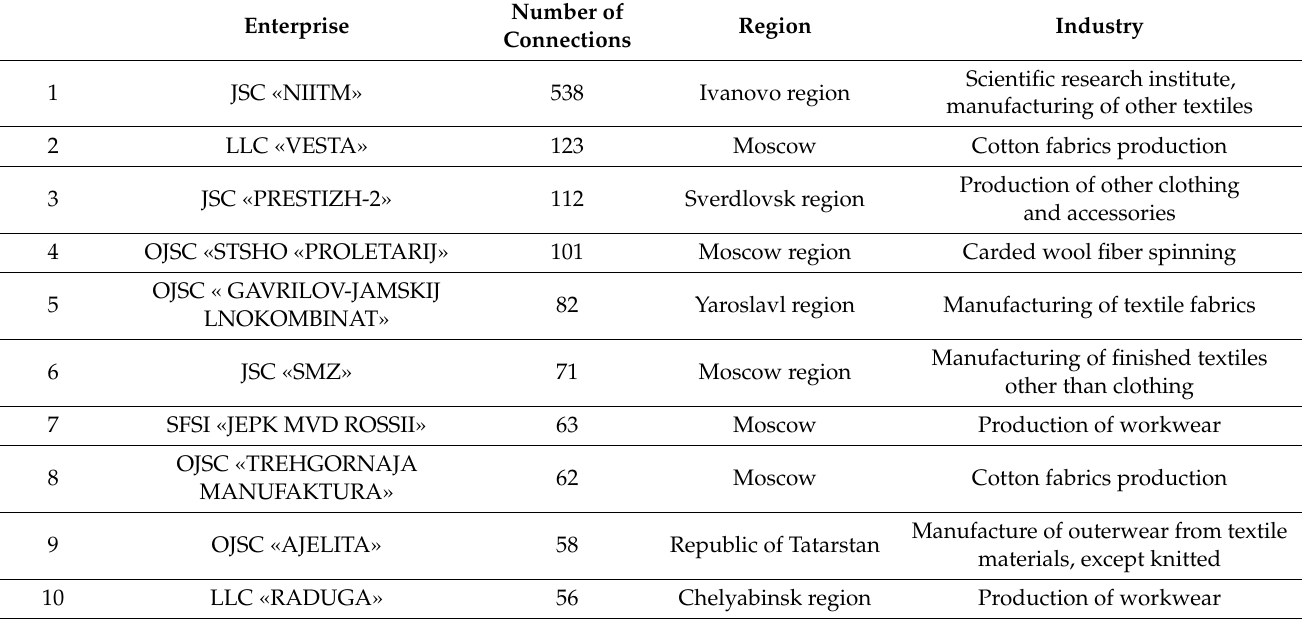
Table A2. Top 30 Russian textile enterprises with the largest number of connections.